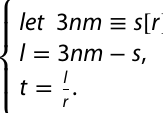
Fig. 5 New Encryption scheme